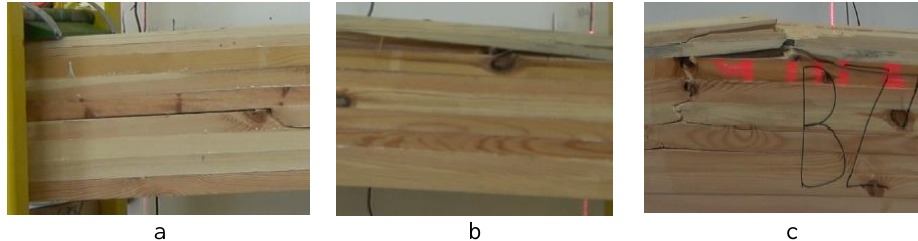
Figure 11. Examples of damage in designed beams (1:15 scale): ( a ) lamella 4/5 (PS), ( b ) knot in lamella 7 (G), ( c ) timber in the tensile zone (example BZ beam no. 1).